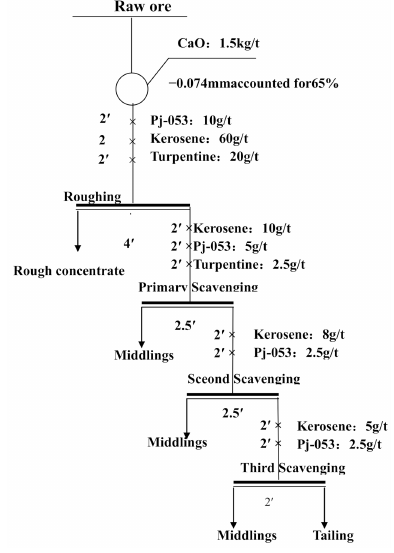
Figure 1. Flotation